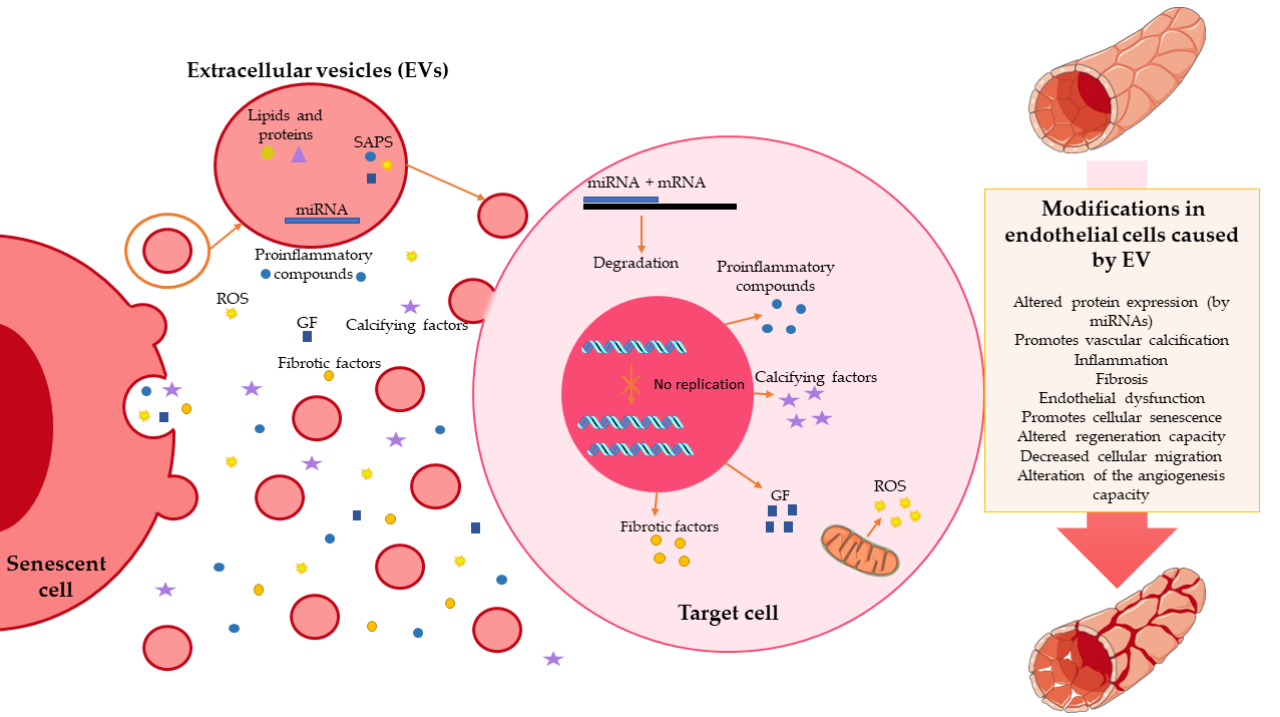
Figure 2. Role of extracellular vesicles in endothelial senescence. Senescence cells release extracellular vesicles that contain multiple factors, such as miRNA; lipids; proteins; and other substances related to senescence-associated secretory phenotype (SAPS), such as proinflammatory compounds, reactive oxygen species (ROS), or growth factors (GF). These compounds reach the target cell and exert multiple functions: alteration of the protein expression exerted by miRNAs; alteration of cell replication; increased production; and the release of proinflammatory, fibrotic, calcifying factors, GF, and ROS. These promote vascular calcification, inflammation, cellular senescence, endothelial dysfunction, and fibrosis.